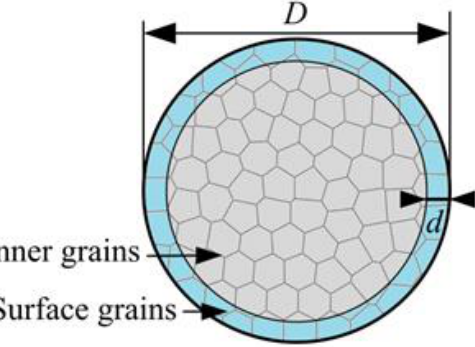
Figure 13. Schematic diagram of specimen diameter and grain size.